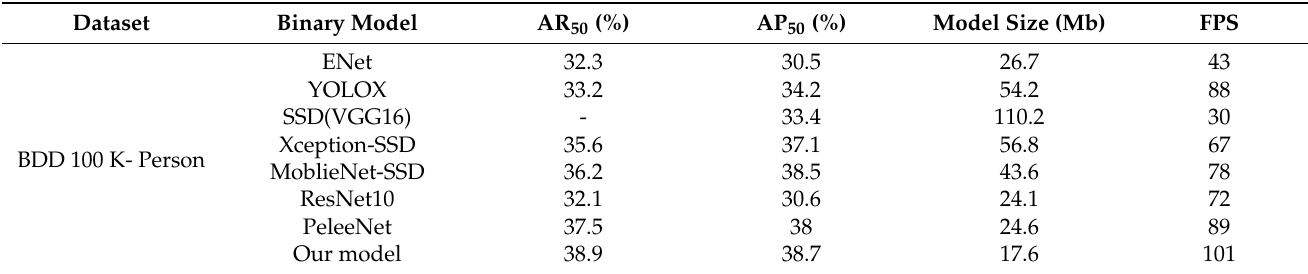
Table 7. BDD 100 K-Person dataset lightweight model comparison experiment.